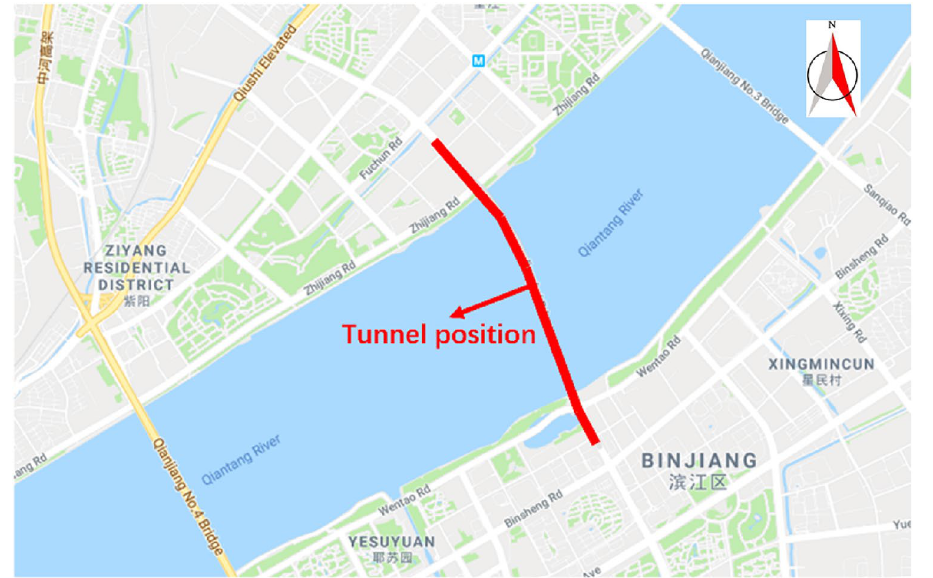
Figure 6. The location of field test (Generated by Baidu map and Microsoft PowerPoints